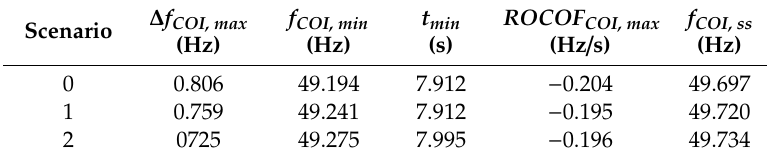
Figure 12. Total active power contribution of synchronous generators (Scenario 0), synchronous generators, DFIM and CFSM (Scenario 1) and synchronous generators, DFIM, CFSM and BESS (Scenario 2) in the year 2030. Table 10. Frequency response indicators of Scenario 0, Scenario 1 and Scenario 2 in the year